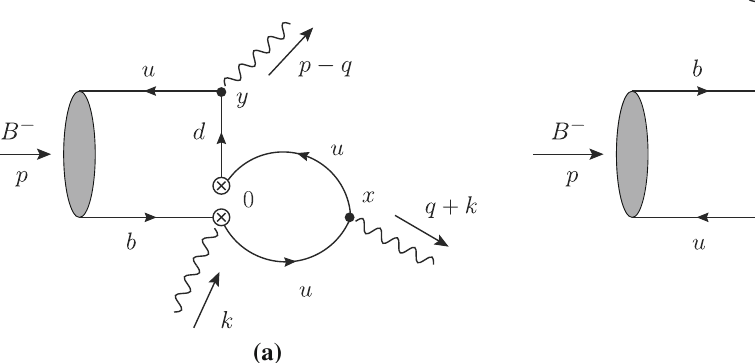
the four-quark operators O 1 , the black dots denote the interpolating currents for final particles and the wiggly lines denote the incoming or outgoing momentum